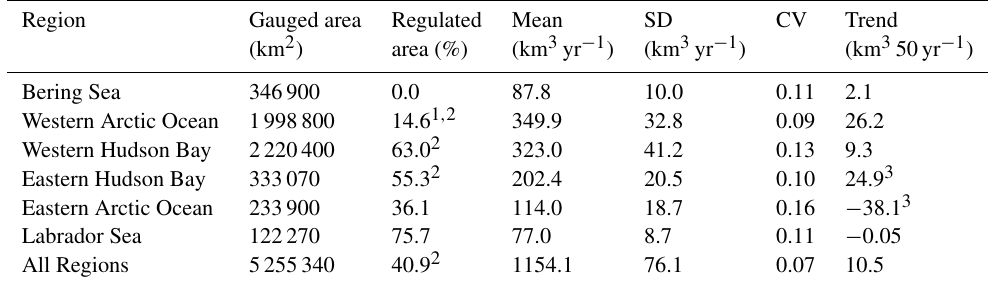
Table 2. Statistics of gauged and regulated area, mean, standard deviation (SD), coefficient of variation (CV) and trend of annual river discharge for six drainage basins in northern Canada, 1964–2013.